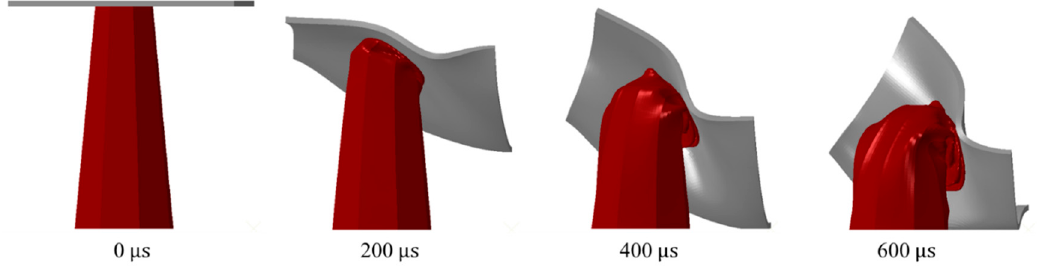
Figure 15. ‘2–1–0.6–5–3’ panel deformation behavior with time.